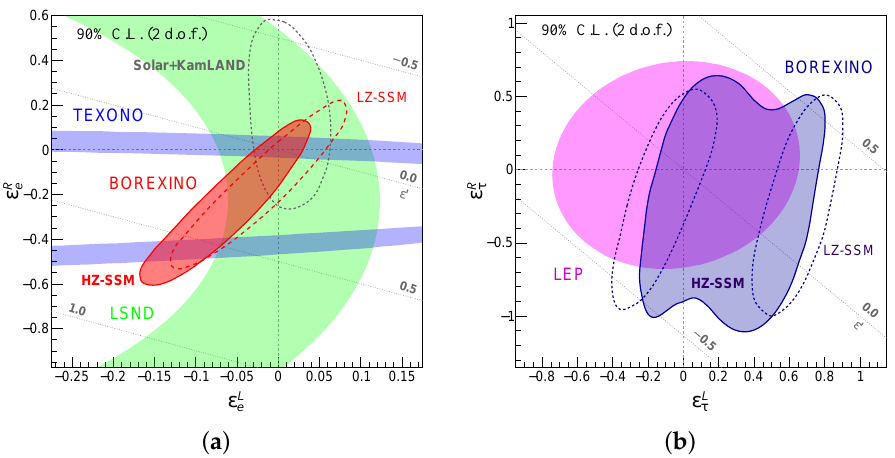
Figure 12. Borexino limits on NSI, using Phase II dataset: ( a ) Allowed region for the NSI parameters ε R e and ε L e . ( b ) Allowed region for the NSI parameters ε R τ and ε L τ . Contours are reported for both HZ-SSM and LZ-SSM metallicity scenarios. The constraints from TEXONO [88], LSND [86,89], and LEP [87] are also provided for comparison. From